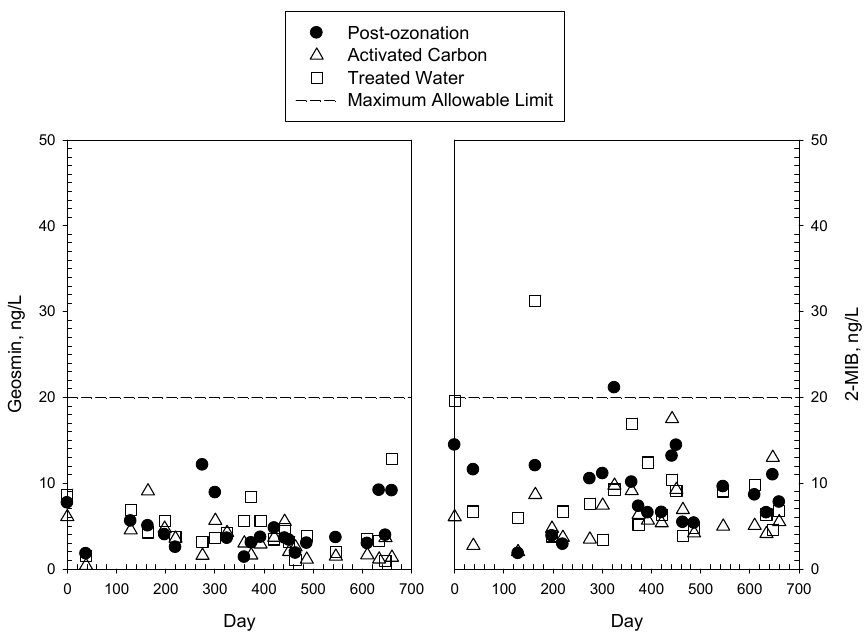
Figure 6. Concentrations of geosmin and 2-MIB affected by the granular activated carbon (GAC) process.